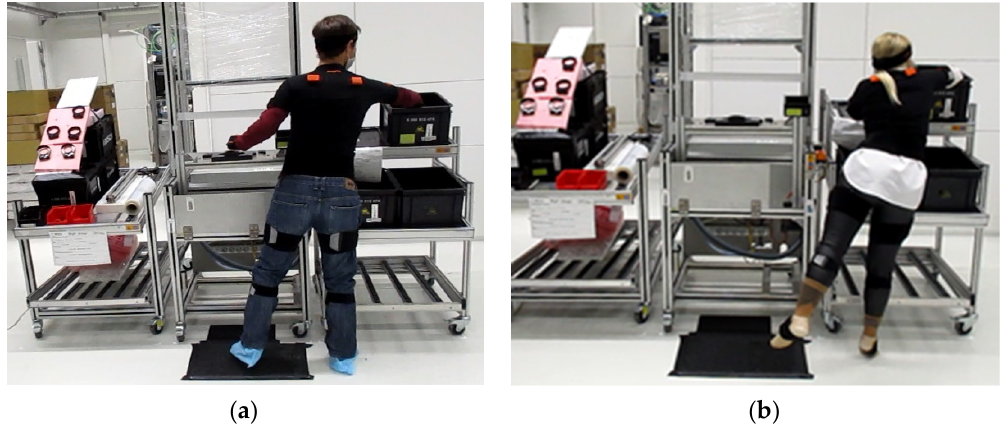
Figure 8. Assembly task with sensors for obtaining RULA scores: ( a ) Highest percentile; ( b ) Lowest percentile. The average percentages of time exposure obtained for each risk level were the fol-